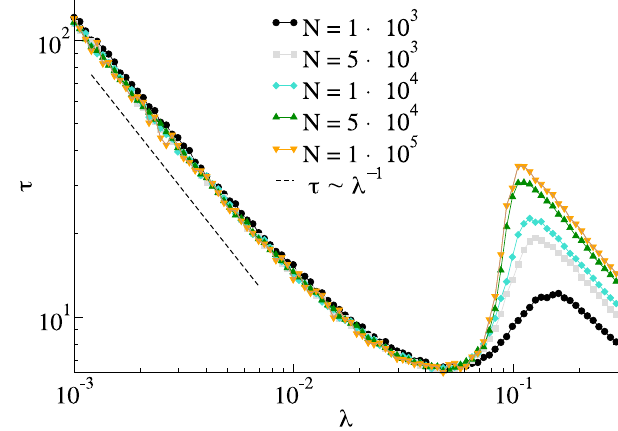
Fig. 3 Time to reach the absorbing state for the standard MT model. Results for α = 1 and different sizes on random regular networks with 〈 k 〉 = 10. The dashed line follows τ k